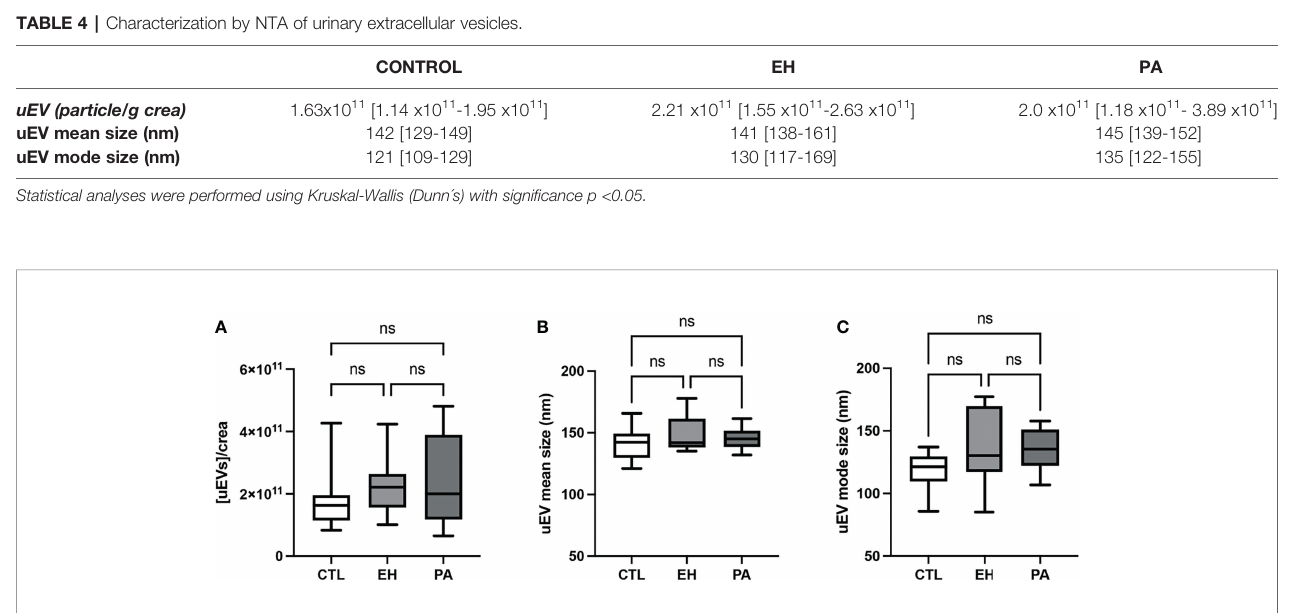
FIGURE 7 | Quanti fi cation of uEVs by NTA. (A) Urinary creatinine normalized uEVs concentration (uEVs particles/mg creatinine). (B) Mean diameter of uEVs particle size distribution (nm). (C) Mode diameter of uEVs particle size distribution (nm). uEVs concentration and diameter were similar between groups. Comparison between groups was performed by unpaired one-way ANOVA or Kruskal-Wallis test. Data are presented as a median and interquartile range [Q1-Q3]. N.S: No signi fi cant difference.